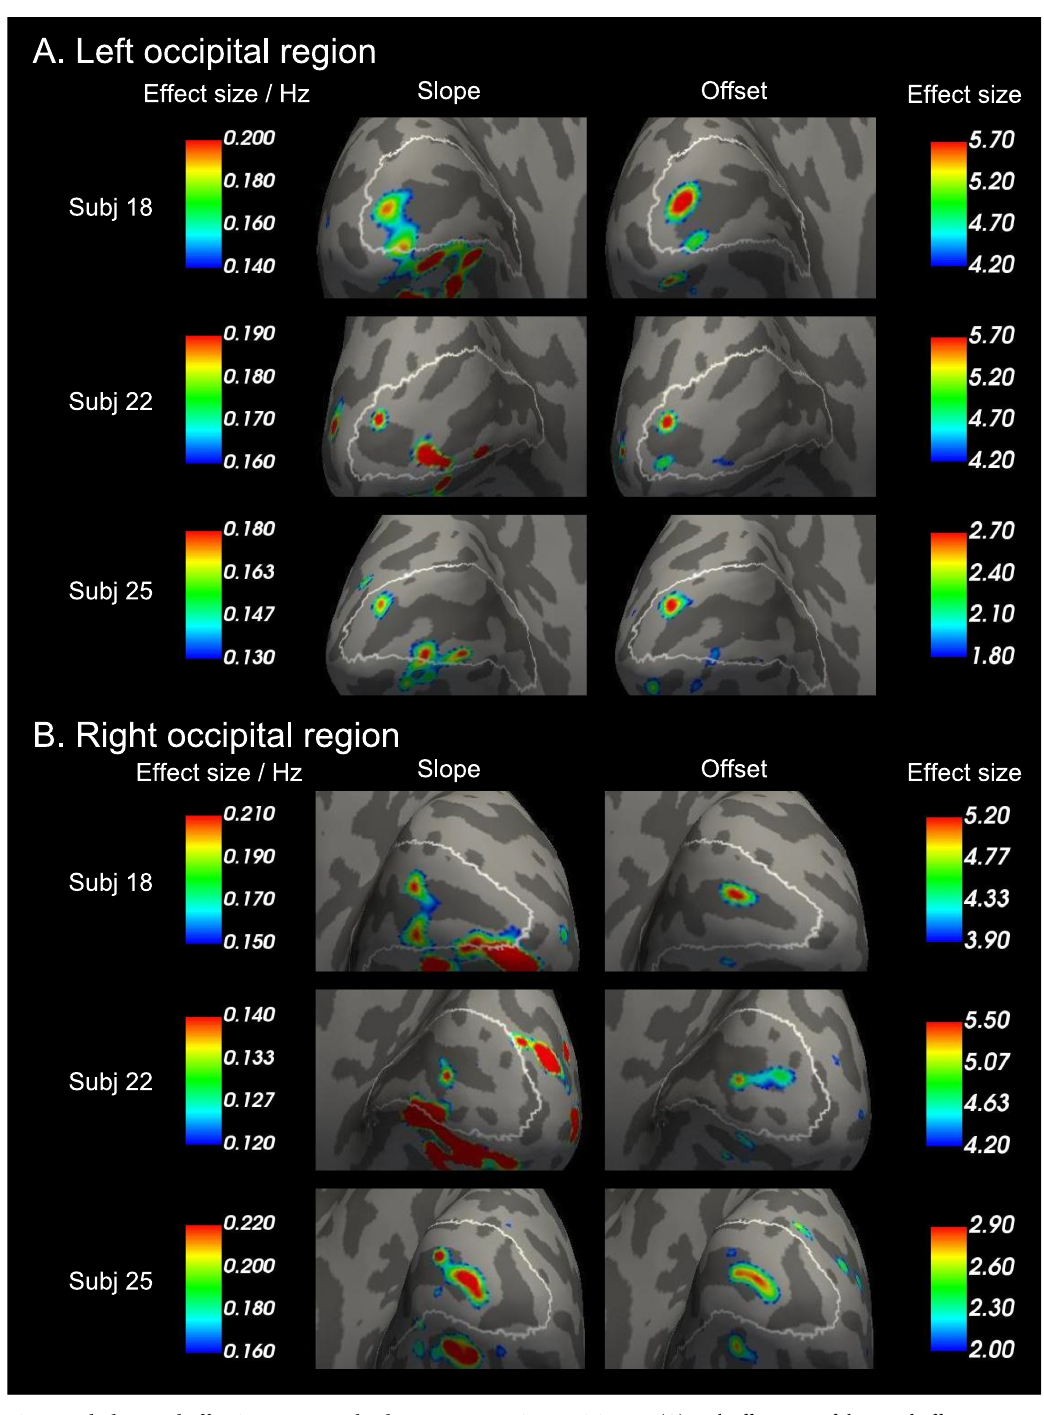
Fig 5. Peak slope and offset in V1 among the three representative participants. (A) Peak effect sizes of slope and offset contrasts are overlaid on an inflated brain surface of each participant in the left occipital region. The brain surfaces are shown from a posterior/medial viewpoint. White lines on the brain surfaces indicate the border of V1, based on cytoarchitecture using vcAtlas [35]. Dark and light gray regions represent sulci and gyri, respectively. Peaks of the slope and the offset within the region bounded by the white lines (i.e., V1). (B) Results in the right occipital region correspond to (A).